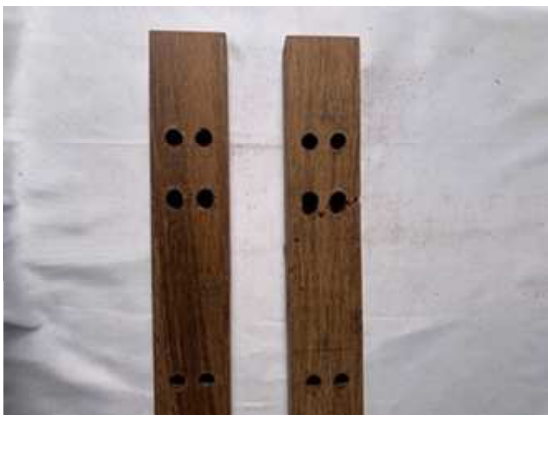
Figure 12. PSB Failure Modes. Figure 13. PSB Failure Modes.